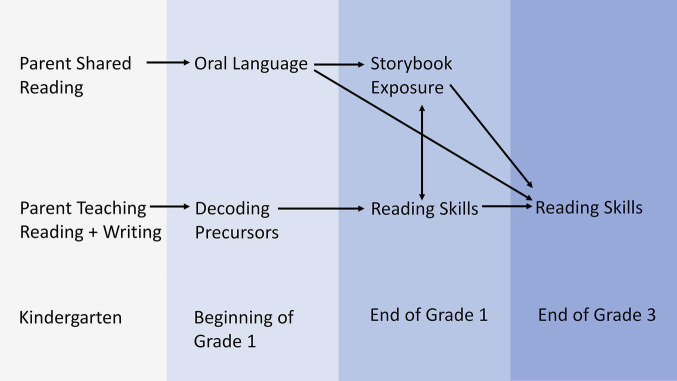
Home Literacy Model (adapted from Sénéchal and LeFevre, 2002). © 2002 by the Society for Research in Child Development, Inc. Adapted with permission.